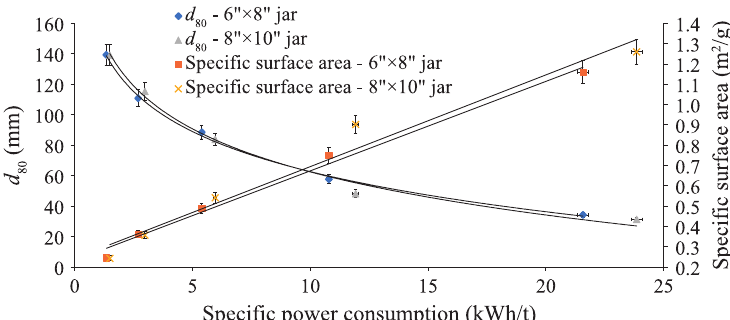
Fig. 7 Specific power consumption as a function of d 80 and specific surface area—Mosaic Tapira sample.